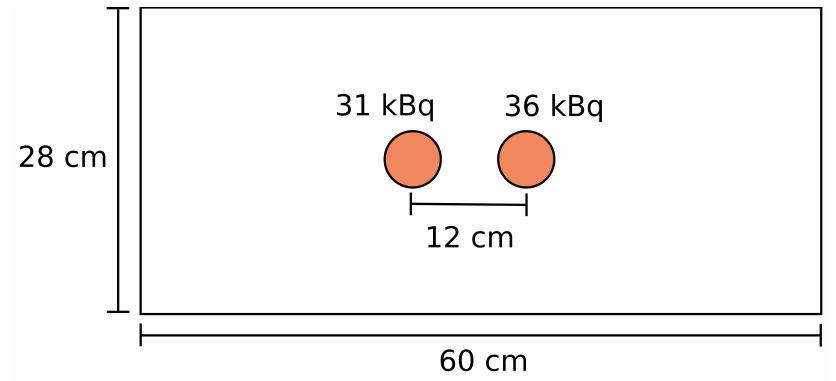
Figure A3. A schematic diagram showing the physical locations of the sources used for scenario